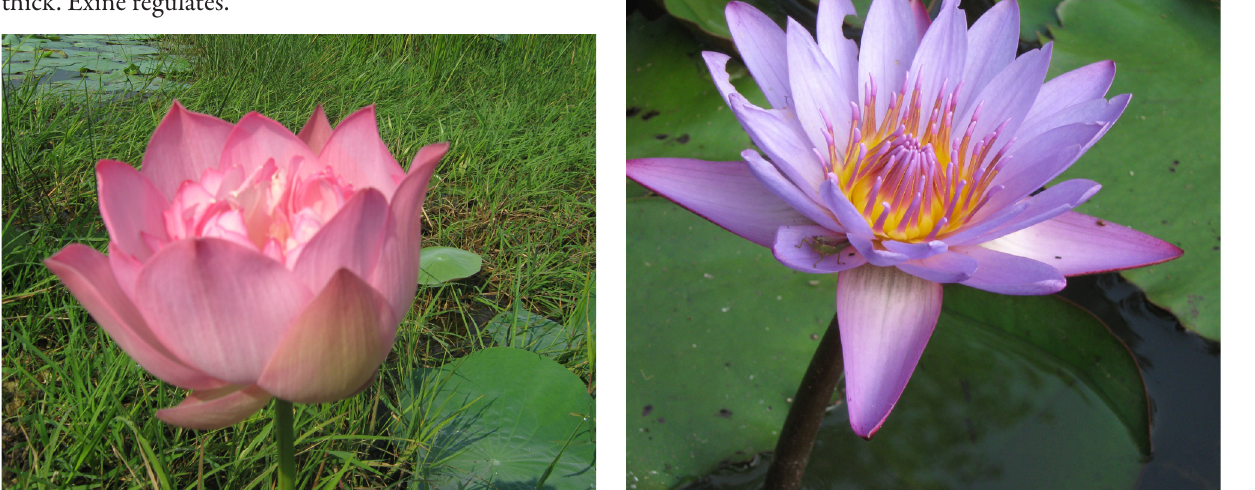
Fig. 4. Flowering twig of Nymphaea micrantha Guillemin et Per-